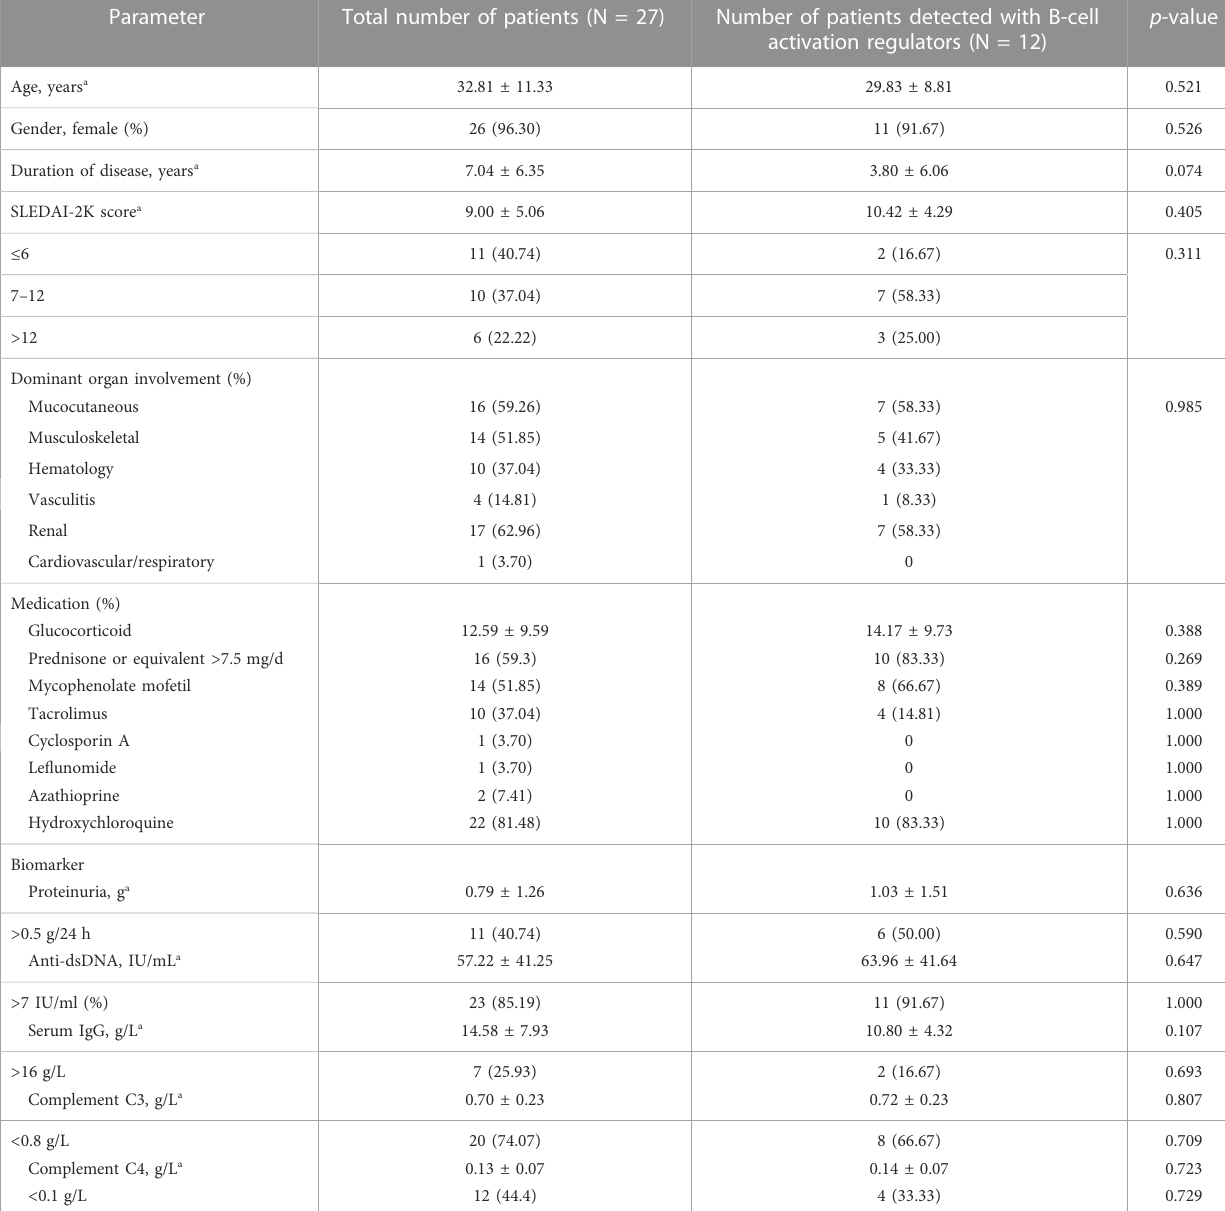
TABLE 1 Demographic and baseline characteristics of SLE patients. Parameter Total number of patients (N = 27) Number of patients detected with B-cell